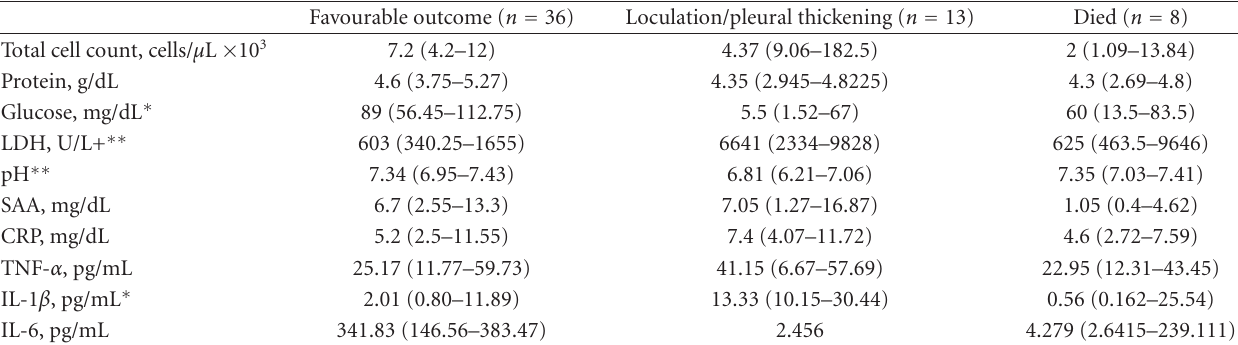
Table 4: Pleural fluid characteristics in PPE according to outcome at 6